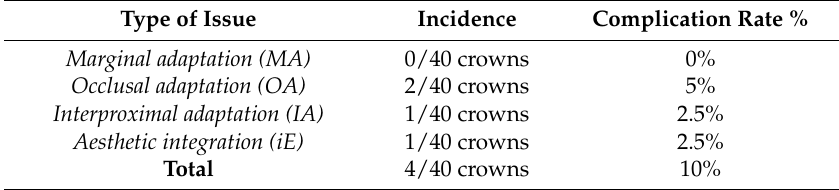
Table 1. Problems encountered at the delivery of the final crowns. Among the problems there were issues with marginal adaptation (MA), occlusal adaptation (OA), interproximal adaptation (IA) and aesthetic integration